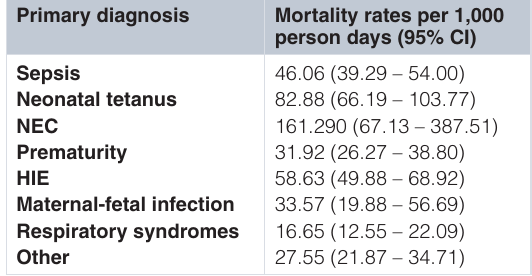
Table 4. Mortality rates per 1,000 person days (95%CI) for the primary diagnoses in Dera Murad Jamali (DMJ).